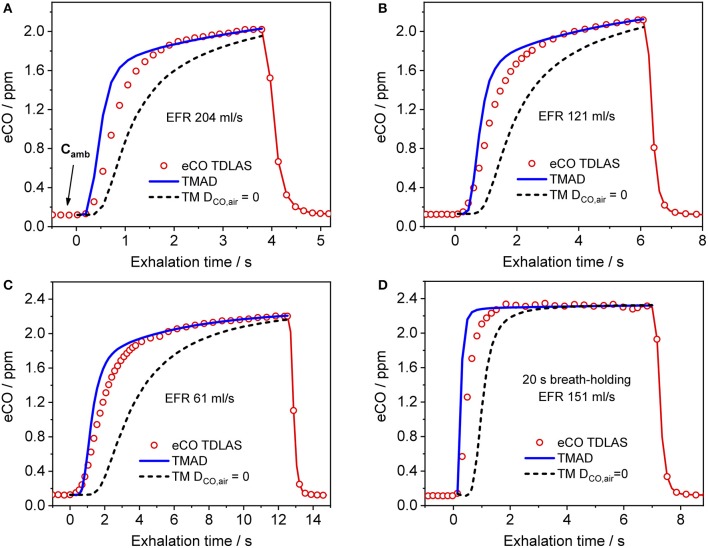
Comparison between measured (hollow markers) and model-predicted (solid lines) eCO profiles for different EFRs (A–C), and 20 s breath-holding (D) for subject 1. For clarity, only every 2nd experimental data point is shown in phase III of the eCO profiles in (B,D), and every 3rd data point is shown in phase III of the eCO profile in (C). Corresponding simulations without axial diffusion (short-dashed lines) are shown in (A–D). EFR, exhalation flow rate.